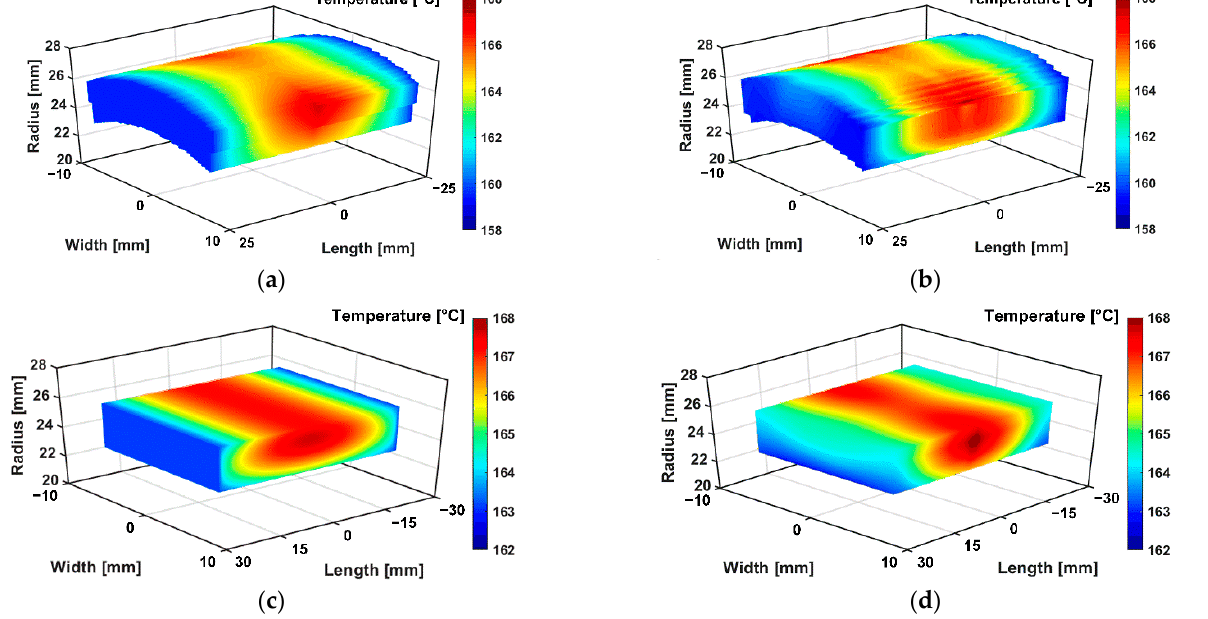
Figure 26. Steady-state 3-D PM temperature distributions predicted by ATMs and 3-D ETFEA. ( a ) SPM (analytical) [60]. (b) SPM (FEA) [60]. ( c ) IPM (analytical) [63]. ( d ) IPM (FEA) [63]. Table 6. Comparison of steady-state average and hotspot temperatures of SPM and IPMs predicted by main thermal analysis methods [60,63].